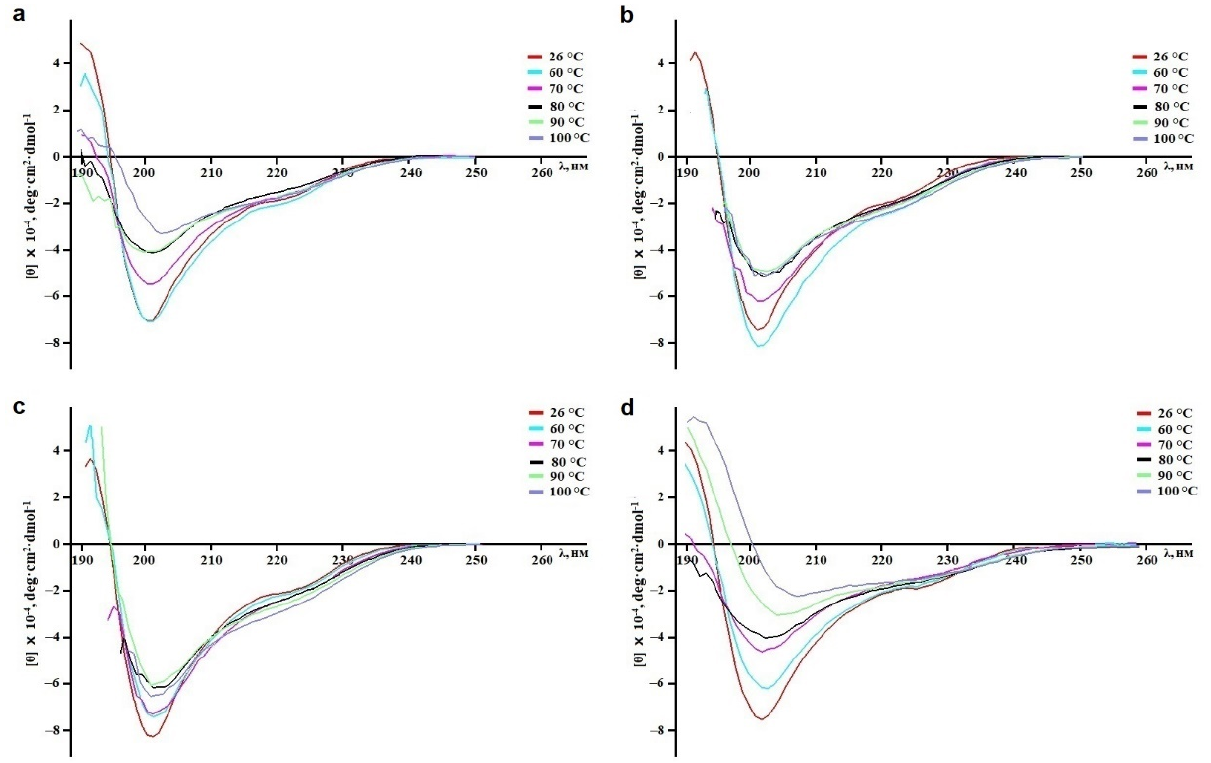
Figure 5. Evaluation of the thermal stability of peptides in deionized water via CD spectroscopy. Recordings of the CD spectra of HCIQ2c1 ( a ), HMIQ3c1 ( b ), HCIQ4c7 ( c ), and HCIQ1c9 ( d ) were conducted in the far UV region (190–240 nm) after the solutions were incubated over a temperature range from 25 °C to 100 °C for 20–25 min.